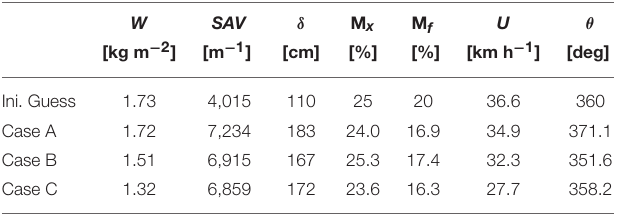
TABLE 2 | Final absolute values for all seven parameters after the assimilation process.